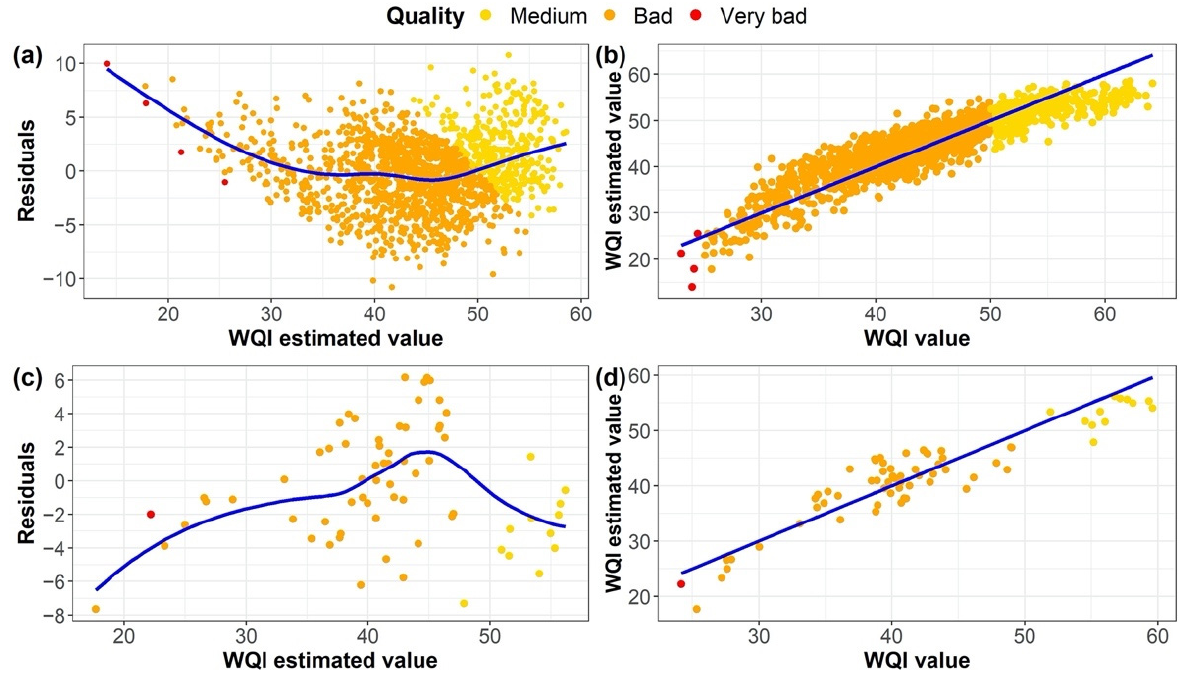
Figure 8. Residuals and fitted values of the multiple linear regression model using 12 parameters. ( a ) Plot of residuals versus the predicted values (using the training data set). ( b ) Real WQI values versus predicted WQI values using the training data set. ( c ) Plot of residuals versus predicted WQI values (using the testing data set). ( d ) Real WQI values versus predicted WQI values (using the testing data set).